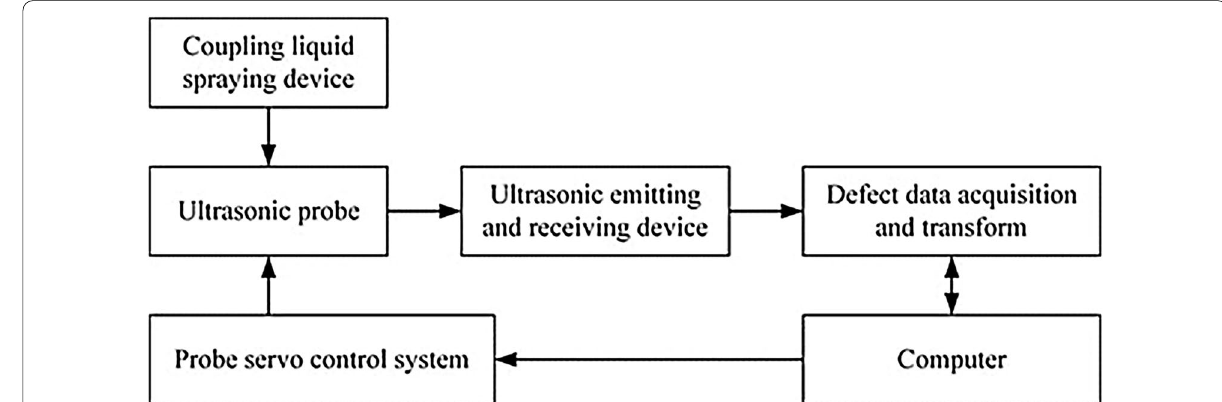
Figure 1 Rail B-scan image acquisition mechanism